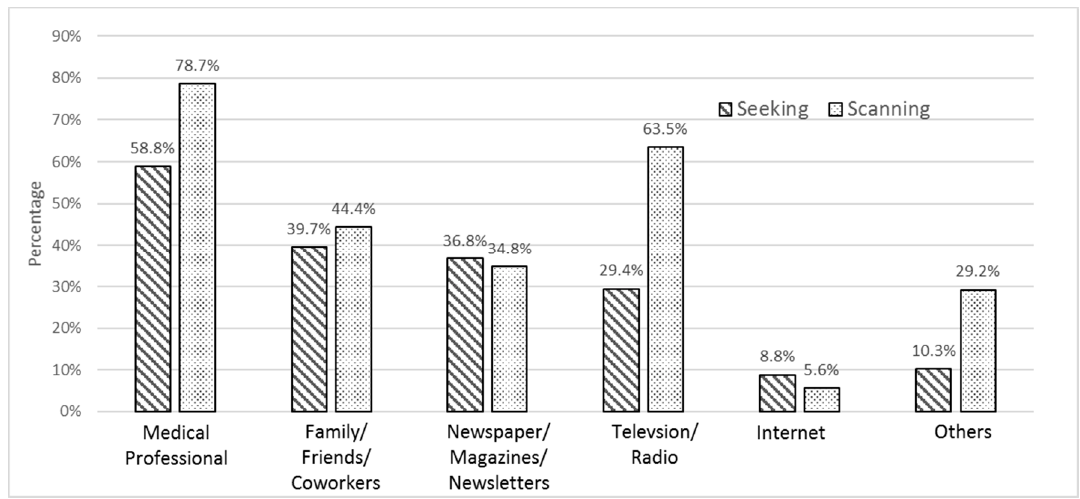
Figure 1. Proportions of cancer-related information seeking and scanning behaviors by source.